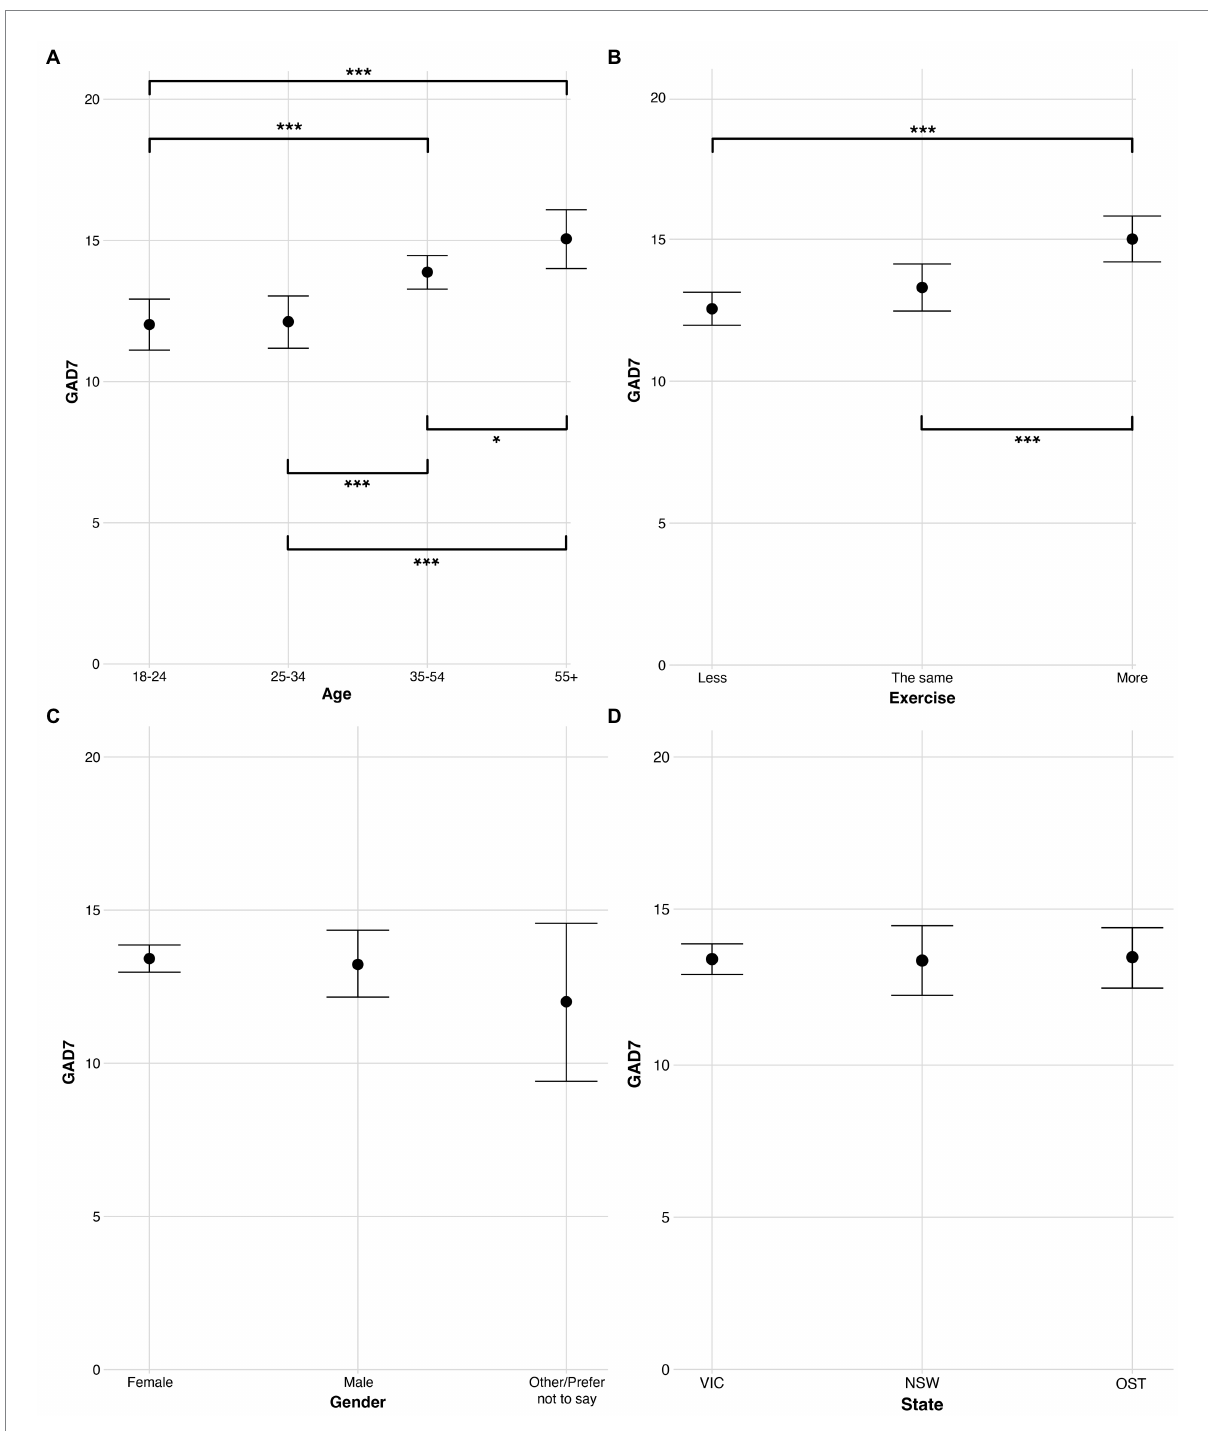
FIGURE 3 Ratings of GAD7 (anxiety) split across levels of the independent variables (A) age, (B) exercise, (C) gender, and (D) state. Error bars are 95% Bayesian credibility intervals. Additionally, evidence ratios 39–60 are denoted with *, evidence ratios 61–90 are denoted with **, and evidence ratios >90 are denoted with